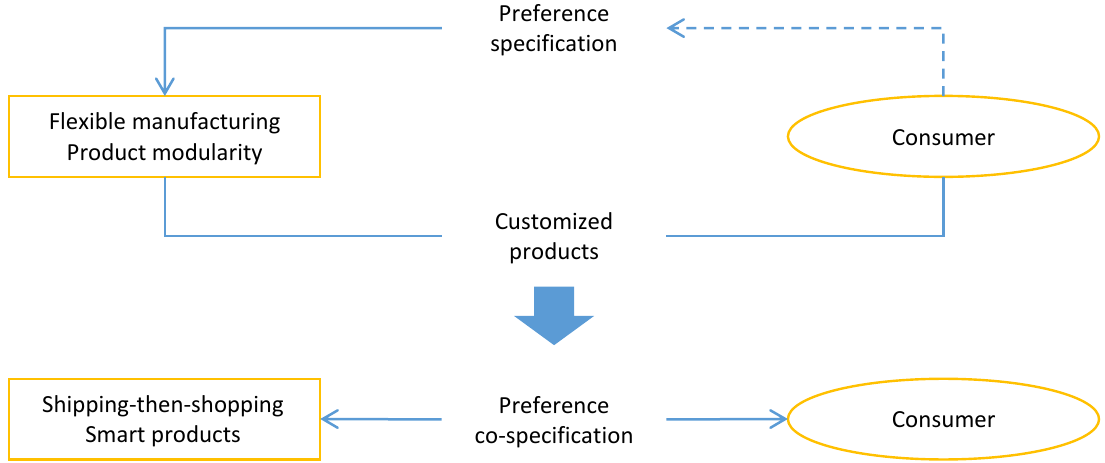
Figure 1. From traditional to AI-based mass customization